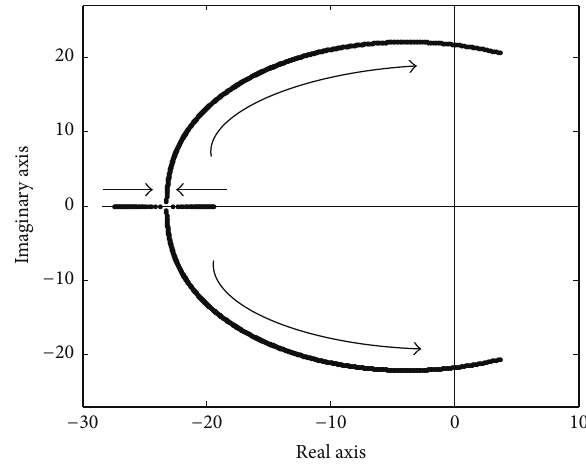
Table 3: The detailed information of predominant poles. Figure 3: Root-locus of the predominant poles.